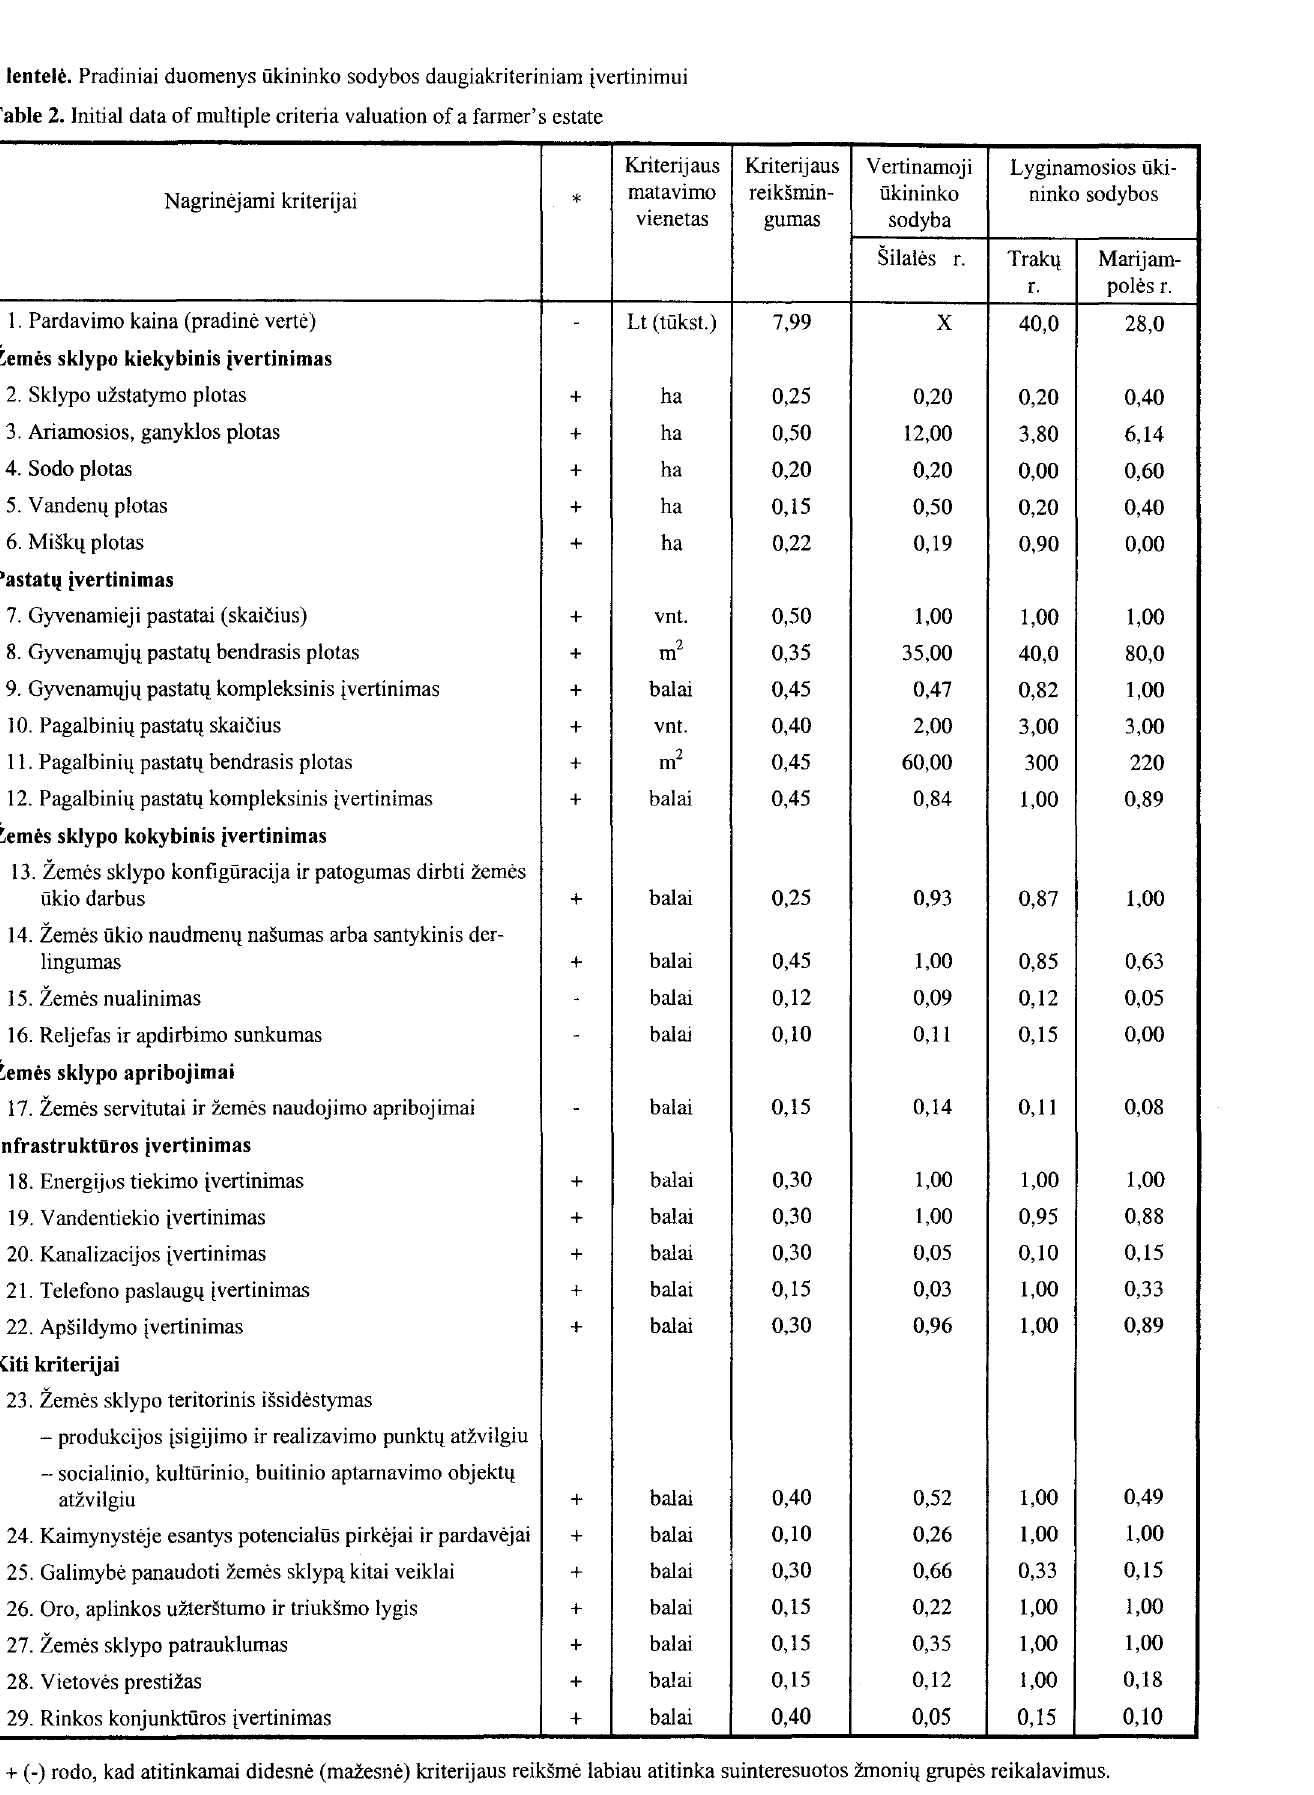
Table 2. Initial data of multiple criteria valuation of a farmer's estate